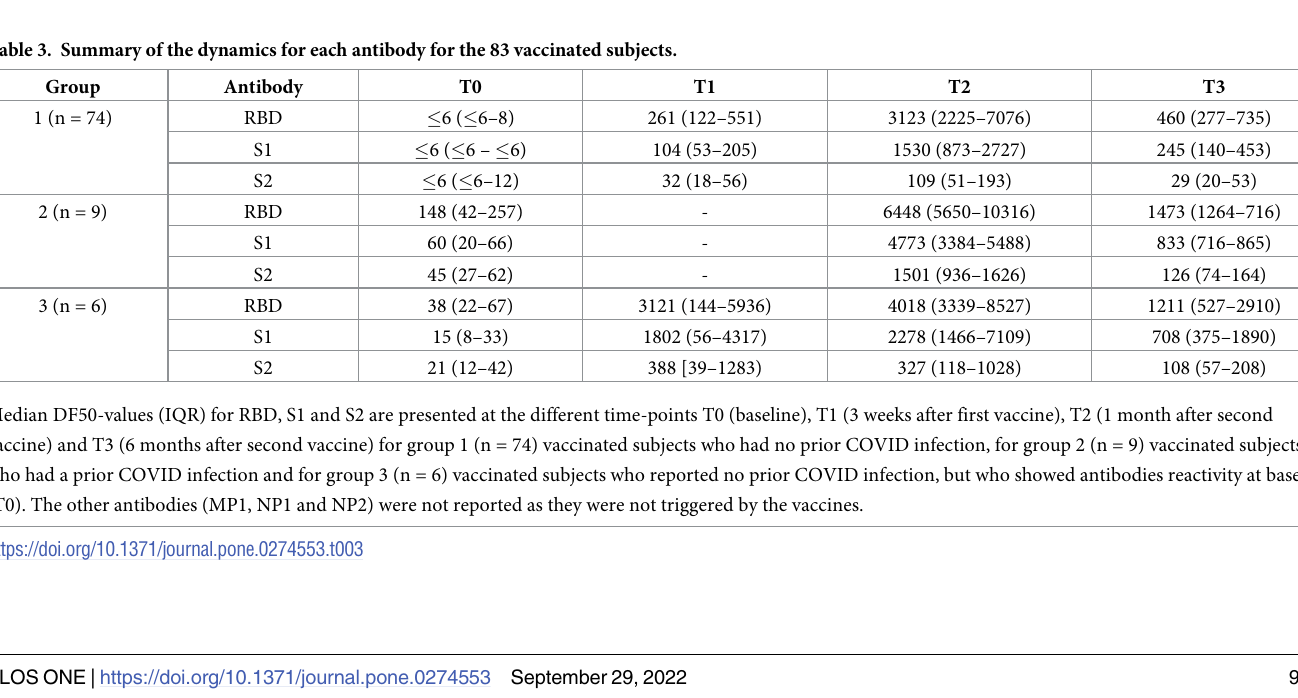
Table 3. Summary of the dynamics for each antibody for the 83 vaccinated subjects. Group